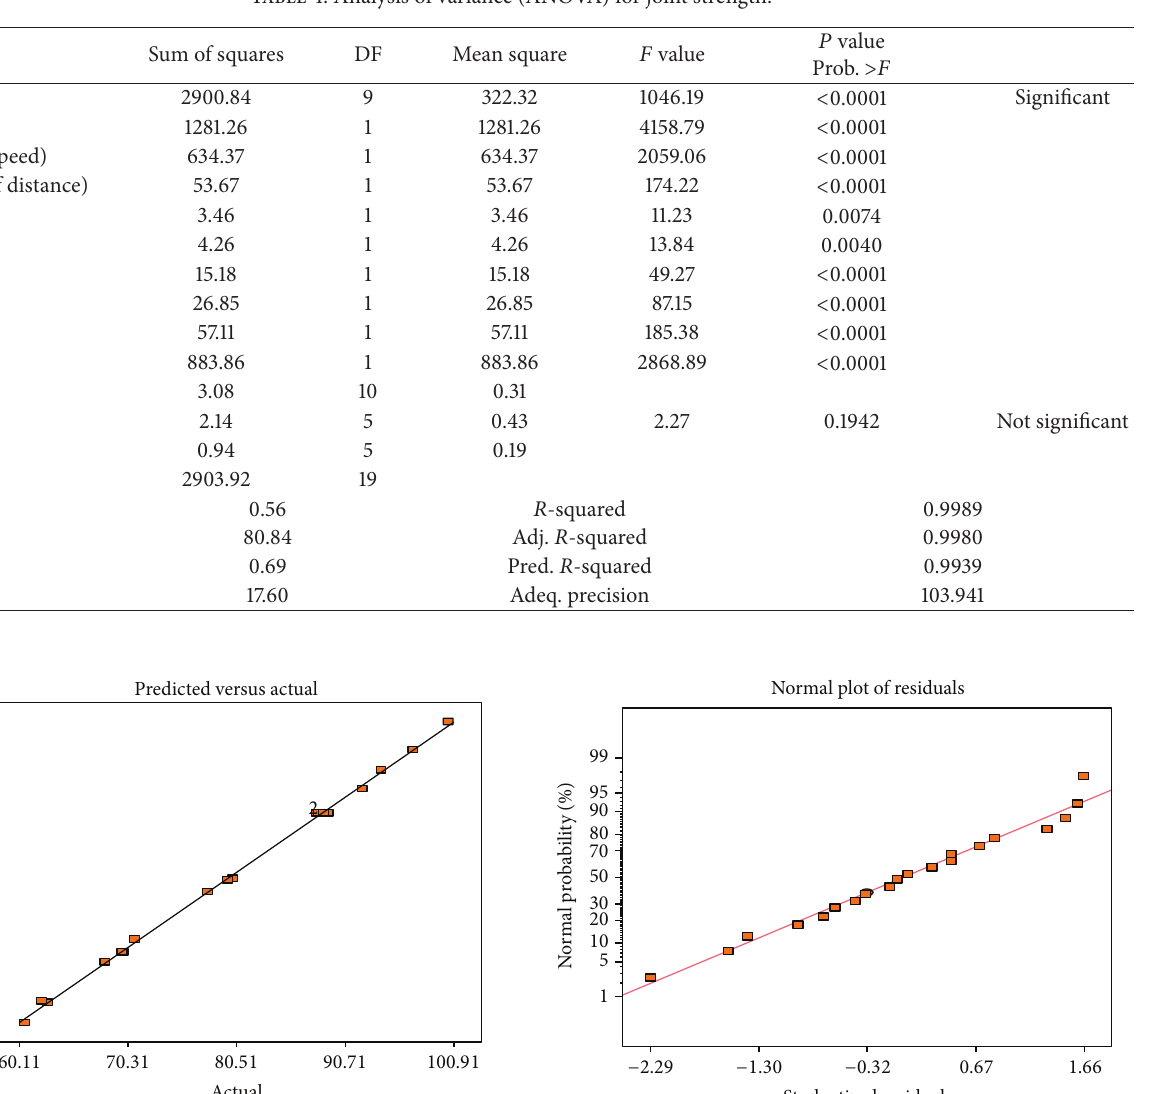
Table 4: Analysis of variance (ANOVA) for joint strength.